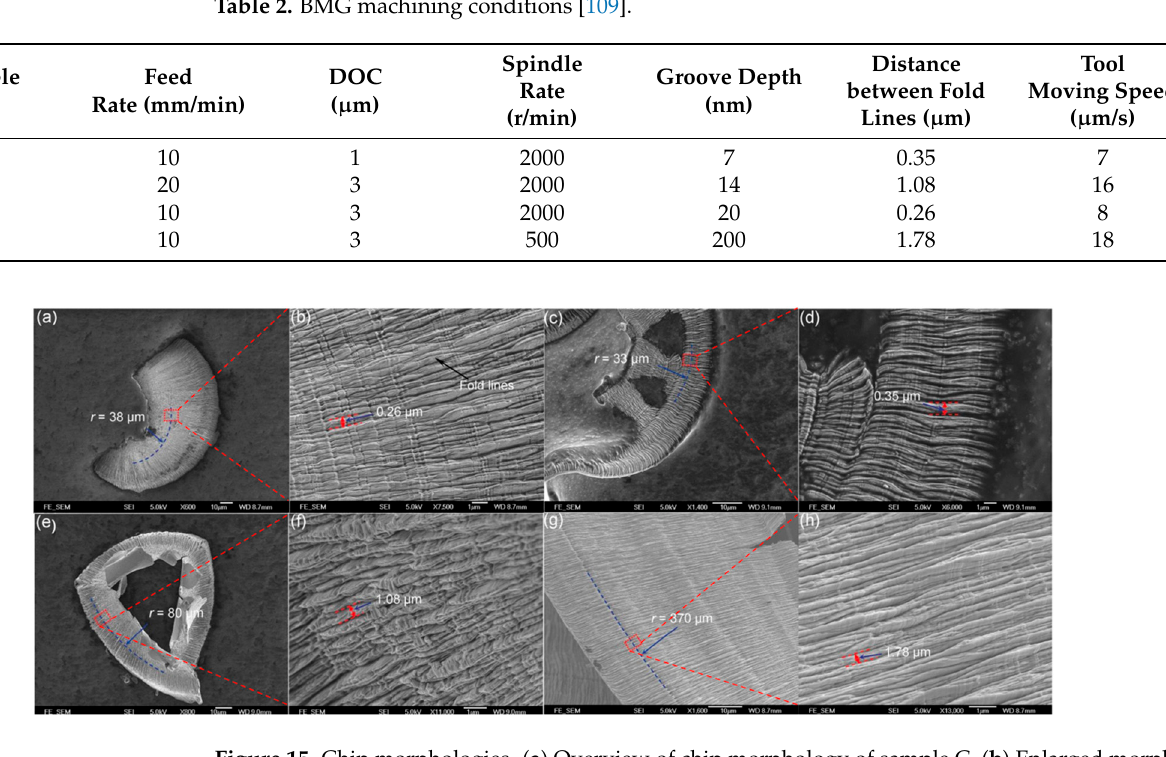
Figure 15. Chip morphologies. ( a ) Overview of chip morphology of sample C. ( b ) Enlarged morphology of the area enclosed in the red rectangle in ( a ). A dark arrow points to the fold line. Distance between neighboring fold lines is also marked. ( c ) Overview of chip morphology of sample A. ( d ) Enlarged morphology of the area enclosed in the red rectangle in ( c ). Distance between neighboring fold lines is also marked. ( e ) Overview of chip morphology of sample B. ( f ) Enlarged morphology of the area enclosed in the red rectangle in ( e ). Distance between neighboring fold lines is also marked. ( g ) Overview of chips’ morphology of sample D. ( h ) Enlarged morphology of the area enclosed in the red rectangle in ( g ). Distance between neighboring fold lines is also marked, reprinted with permission from Ref. [109] 2015, Elsevier.